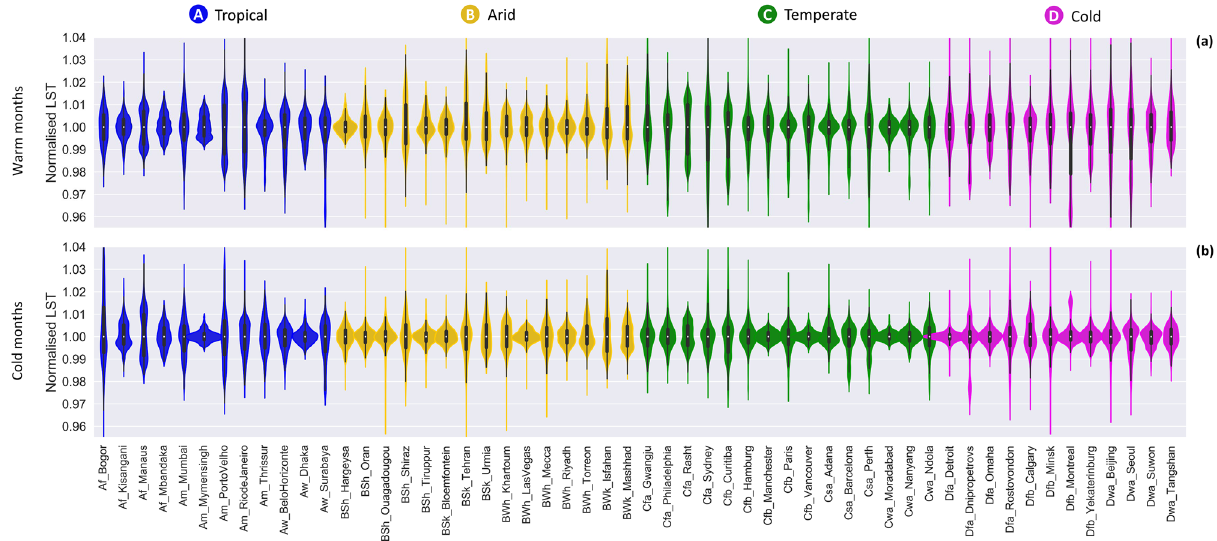
Figure 4. Violin plot illustrating the range and distribution of LST values for 54 cities. Coloured areas represent the distribution of the values. White dots within the violin plots depict the median values. ( a ) Normalised LST in warm months. ( b ) Normalised LST in cold